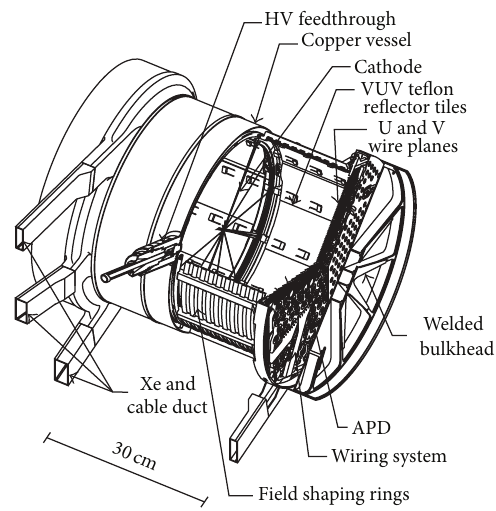
Figure 1: Details of the EXO-200